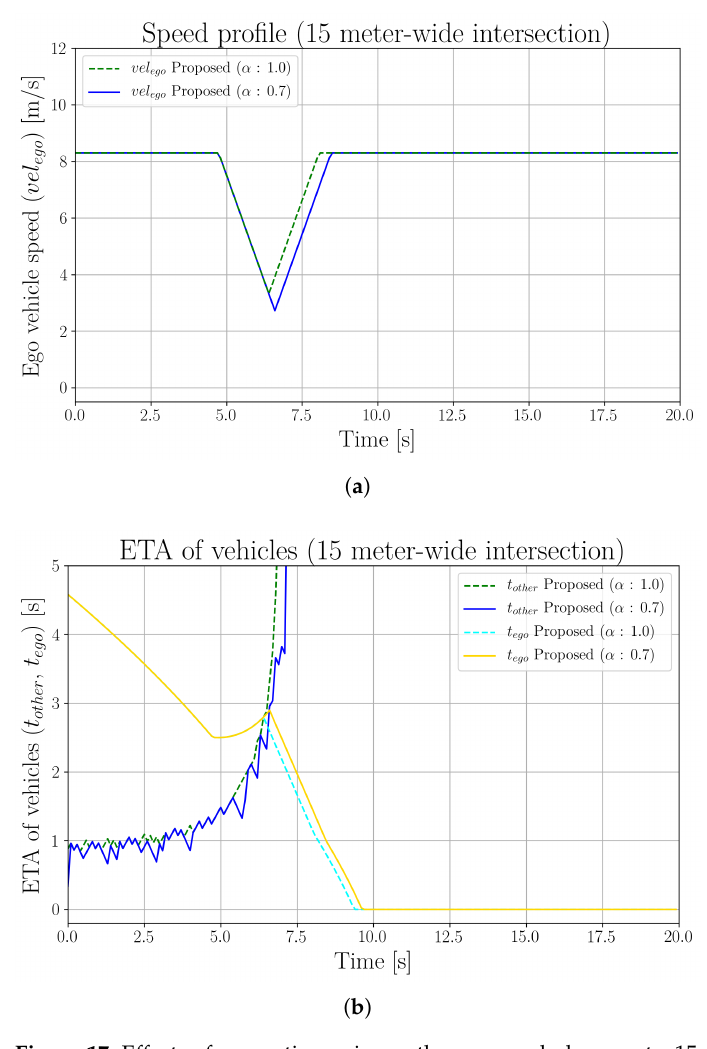
Figure 17. Effects of perception noise on the proposed planner at a 15 m wide occluded intersection. ( a ) Ego vehicle speed profiles at a 15 m wide occluded intersection. ( b ) Estimated times of arrival of vehicles at a 15 m wide occluded